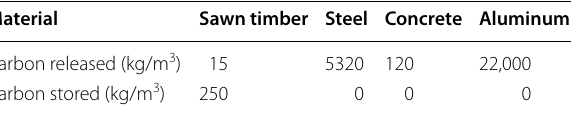
(cid:13)lesTimberBricksSteelTimberSteelTimberAluminiumTimber Tonnes: CO -equiv. 2 Fig. 2 Greenhouse gases emitted in the manufacture of building materials used in a range of construction components for a single storey house in Sydney, Australia. Modified from Australian Government, Forest and Wood Products Research and Development Corporation (2006) Table 2 Carbon released in the manufacture of build- ing materials compared with carbon stored in